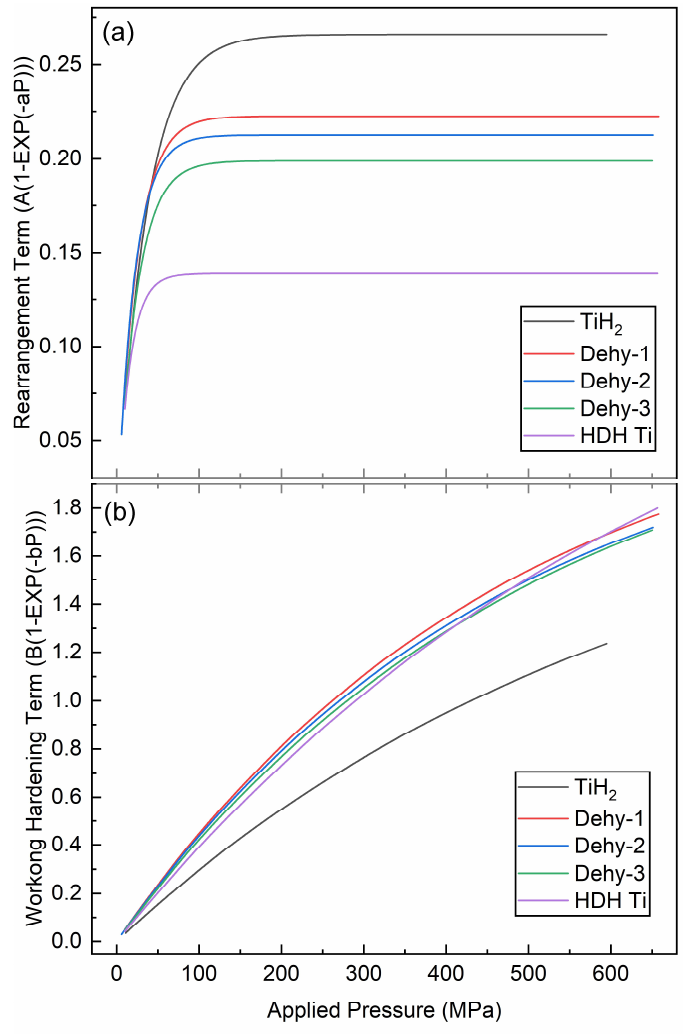
Figure 10. The contributions of particle rearrangement ( a ) and plastic deformation ( b ) mechanisms on densification according to Equation (3). The five powders are distinguished as follows: TiH 2 , Dehy-1, Dehy-2, Dehy-3 and HDH Ti.